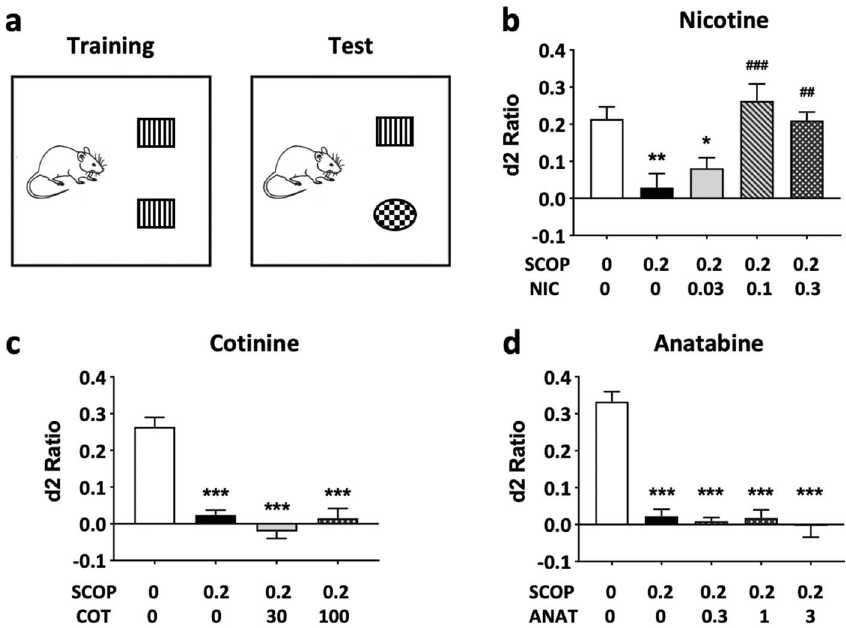
Figure 3. Effects of alkaloids on NOR short-term memory. ( a ) Schematic diagram of the NOR test is shown. The familiar objects are indicated as squares with stripes, and the new object is indicated as a checkered round object for presentation purposes. The test was conducted 3 h after training. The discrimination ratios (d2) are presented for ( b ) nicotine (NIC), ( c ) cotinine (COT), and ( d ) anatabine (ANAT). Only nicotine was able to significantly suppress scopolamine (SCOP)-induced memory deficit at 0.1 and 0.3 mg/kg. Doses are indicated below each graph in mg/kg b.w. *p < 0.05, **p < 0.01, and ***p < 0.001 compared with vehicle control without scopolamine (white bars). ## p < 0.001 and ### p < 0.001 compared with vehicle control with scopolamine (black bars). Grey bars are the lowest, bars with slashes are the medium, and checkered bars are the highest concentrations tested of the respective compounds. Data are expressed as mean ±